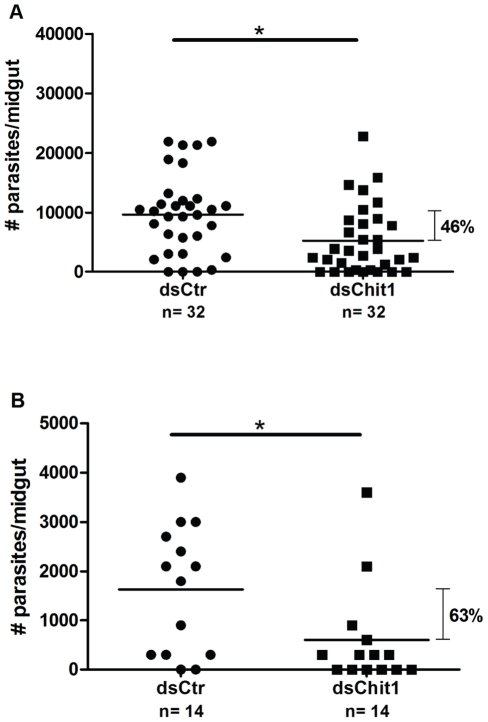
dsRNA effect on Le. major development.Intra-thoracic injections of dsPpChit1 (80.5 ng) reduce Le. major load in P. papatasi midgut. (A). At 48 h PBM, Le. major density was reduced on average 46% in dsPpChit1 (dsChit1) injected compared with dsControl (dsCtr) injected. (B). Le. major parasites per midgut were further reduced at 120 h PBM in dsPpChit1 injected flies, reaching on average 63% reduction over the dsControl injected ones. Each dot represents parasite number in a single P. papatasi midgut. Horizontal bars display mean parasite numbers. n: Number of flies analyzed. *: Statistically significant at p<0.05. Graphs represent one similar result of two independent experiments.